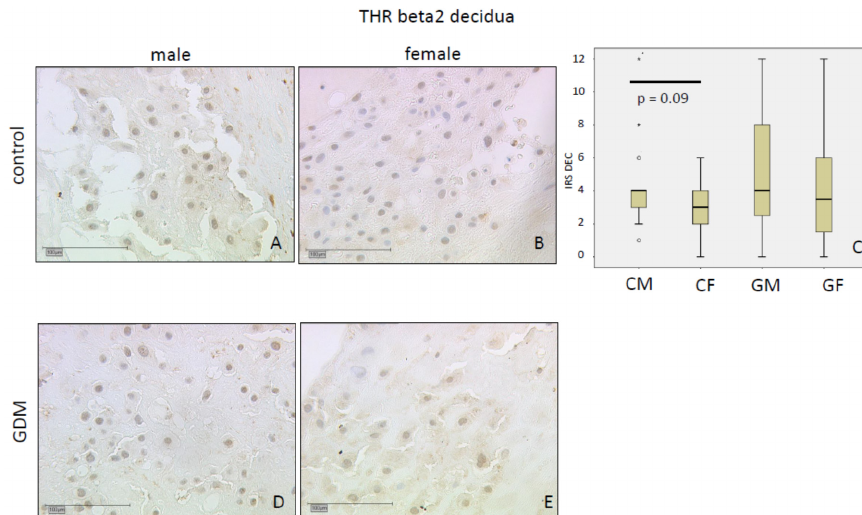
Figure 6. THR β 2 immunoreactivity is found with low intensity in normal decidua ( A , B ) and GDM ( D , E ). THR β 2 is higher in male than female decidua. IRS scores for each group are shown as Box plots (IRS DEC) ( C ). The boxes represent the range between the 25th and 75th percentiles with a horizontal line at the median. The circles indicate values more than one and a half box lengths, and the asterisk values more than three box lengths from the 75th percentile. Groups are labelled as follows: CM = control male; CF = control female; GM = GDM male; GF = GDM female. Scale bar = 100 µm.